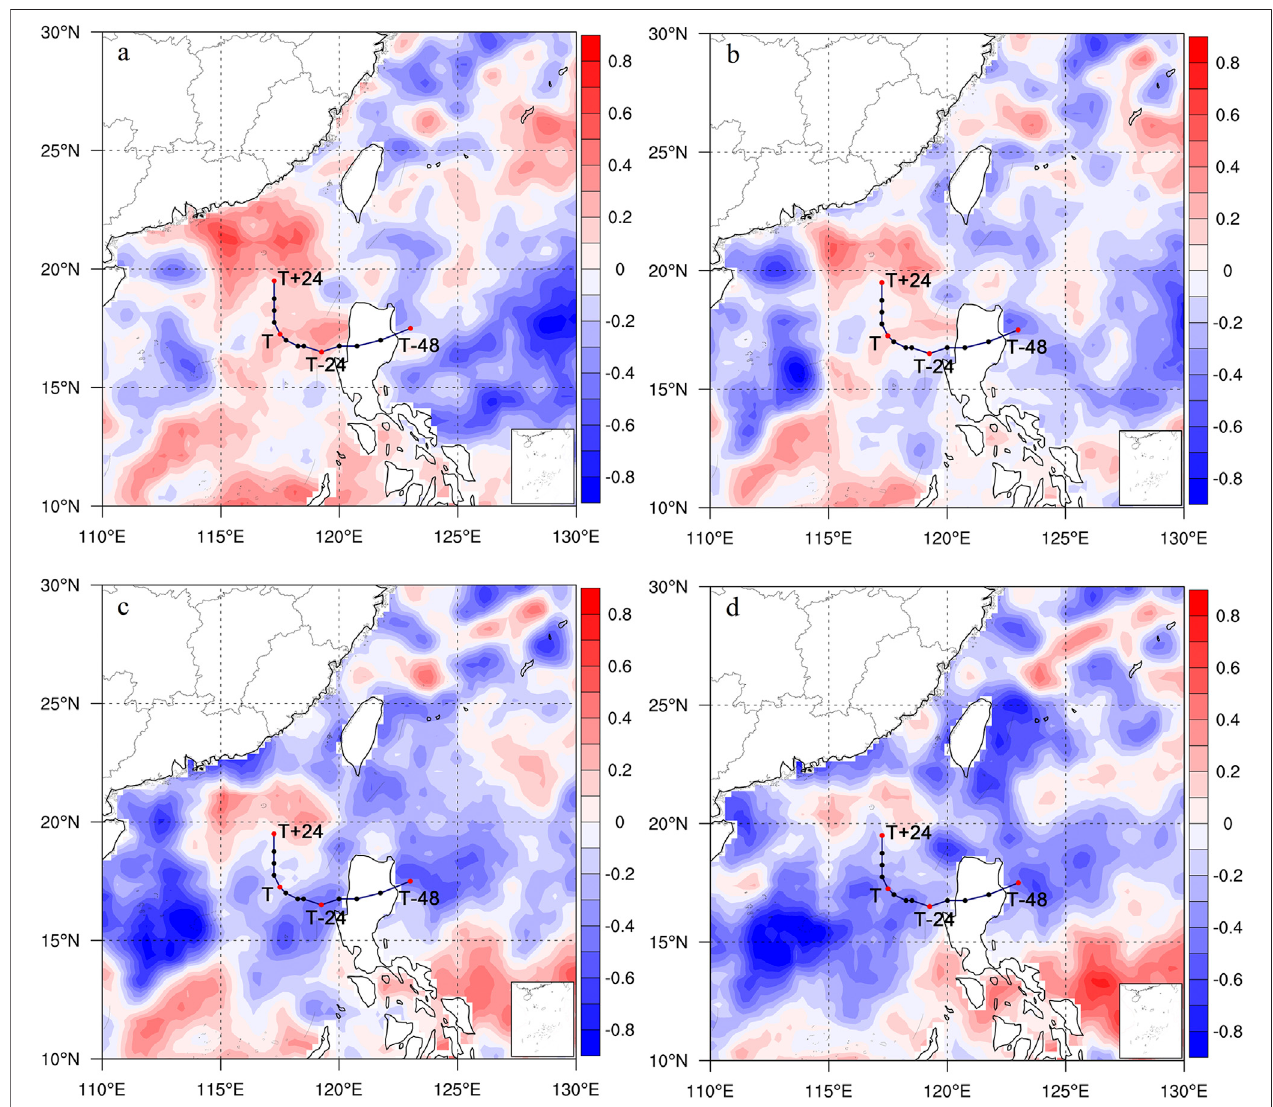
FIGURE 8 | The distribution of abnormal daily SST at different stages (shaded contours, Unit: ° C). (A) T-48, (B) T-24, (C) T, (D) T+24. (Solid line with dots is the composed typhoon track).